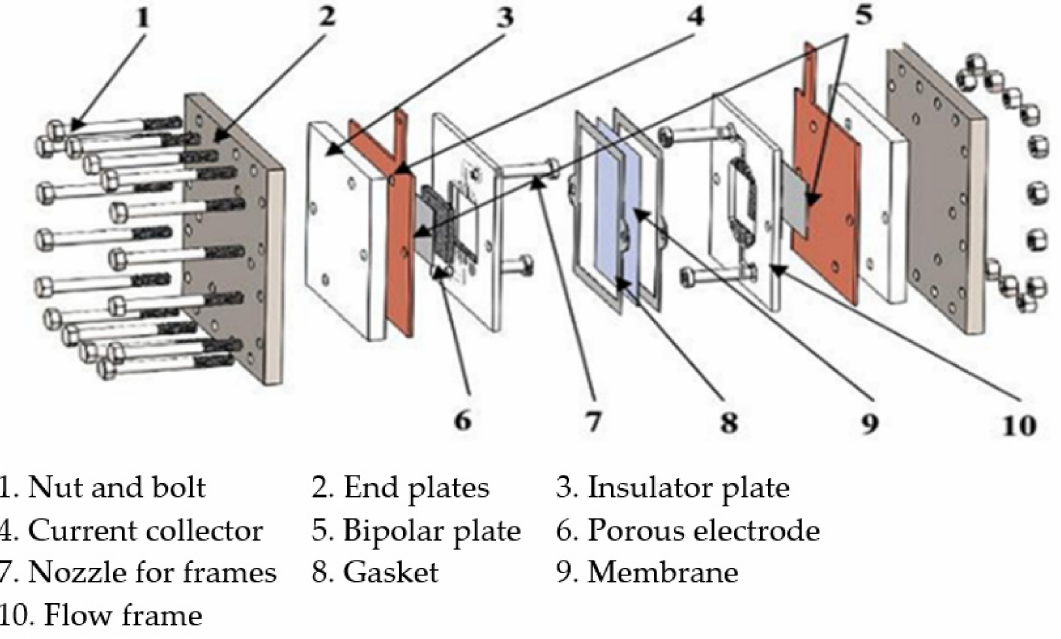
Figure 2. Components of VRFB single